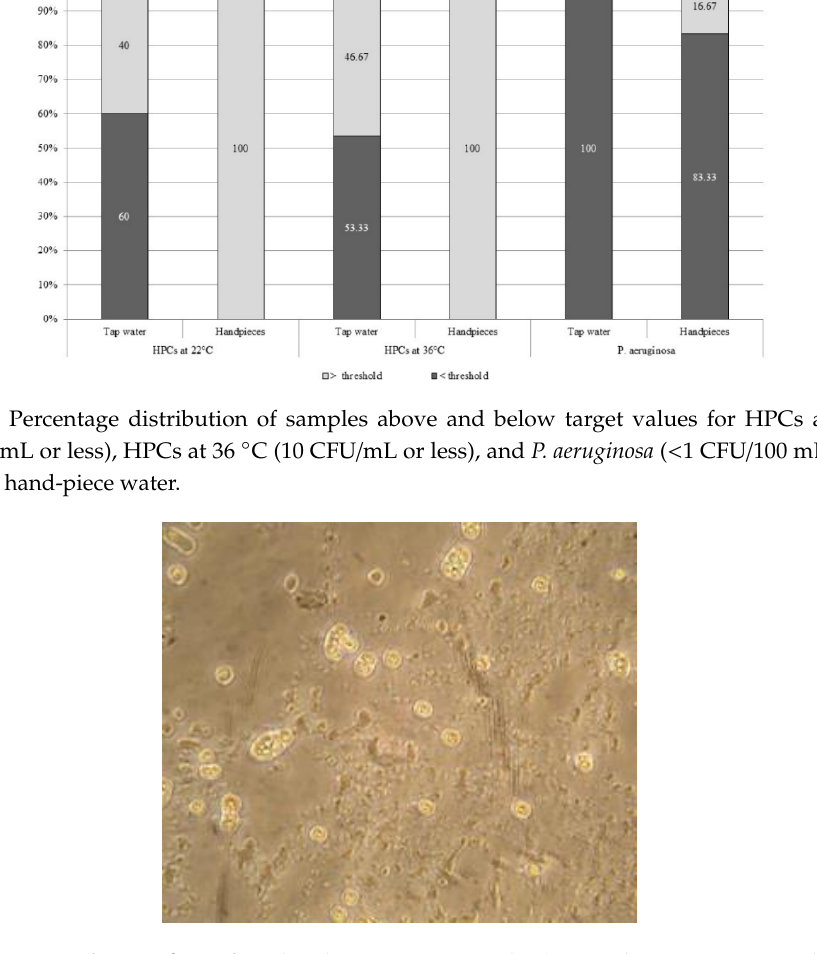
Figure 2. Vermamoeba vermiformis from hand-piece water samples (inverted microscope, 40× objective).